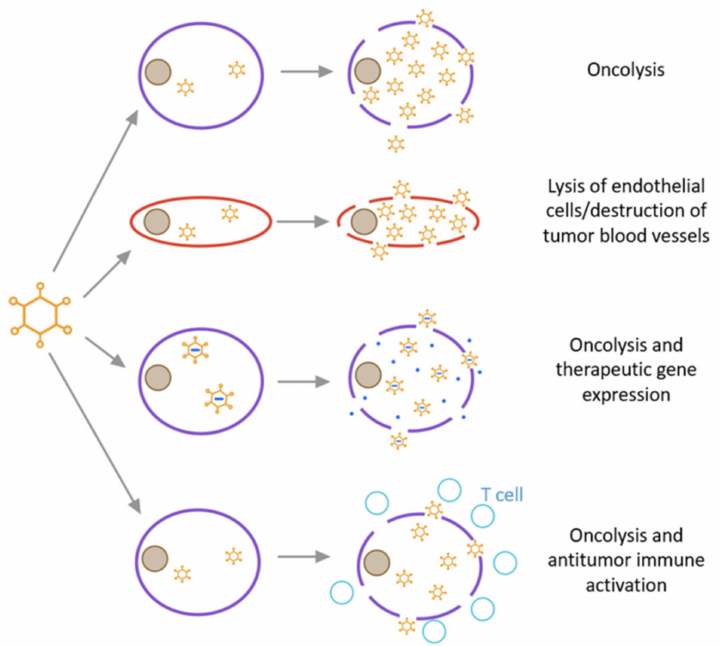
Figure 6. Types of oncolytic viruses and their mode of